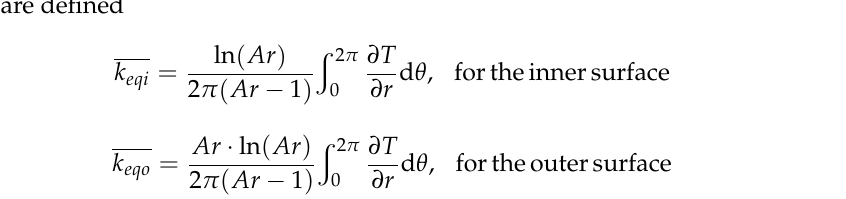
Table 6. Comparison of average equivalent heat conductivity at different Rayleigh numbers.